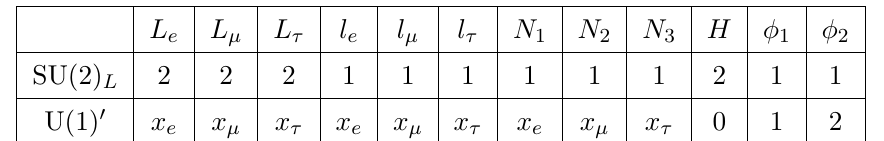
and (cid:30) transforming as 1 and 2 under 1 2